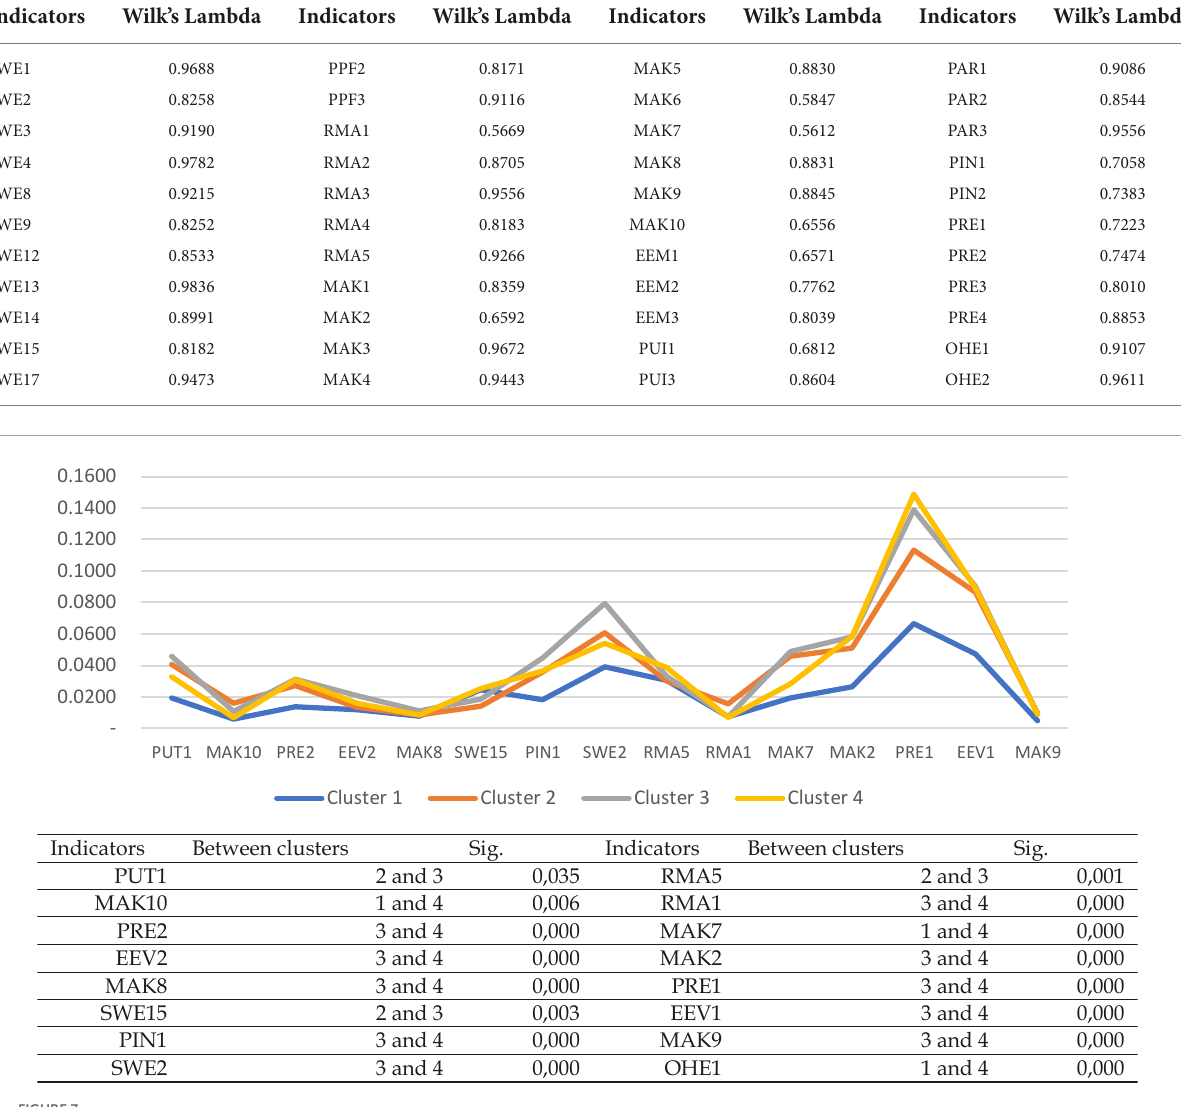
TABLE 5 Wilk’s Lambda test statistical results.